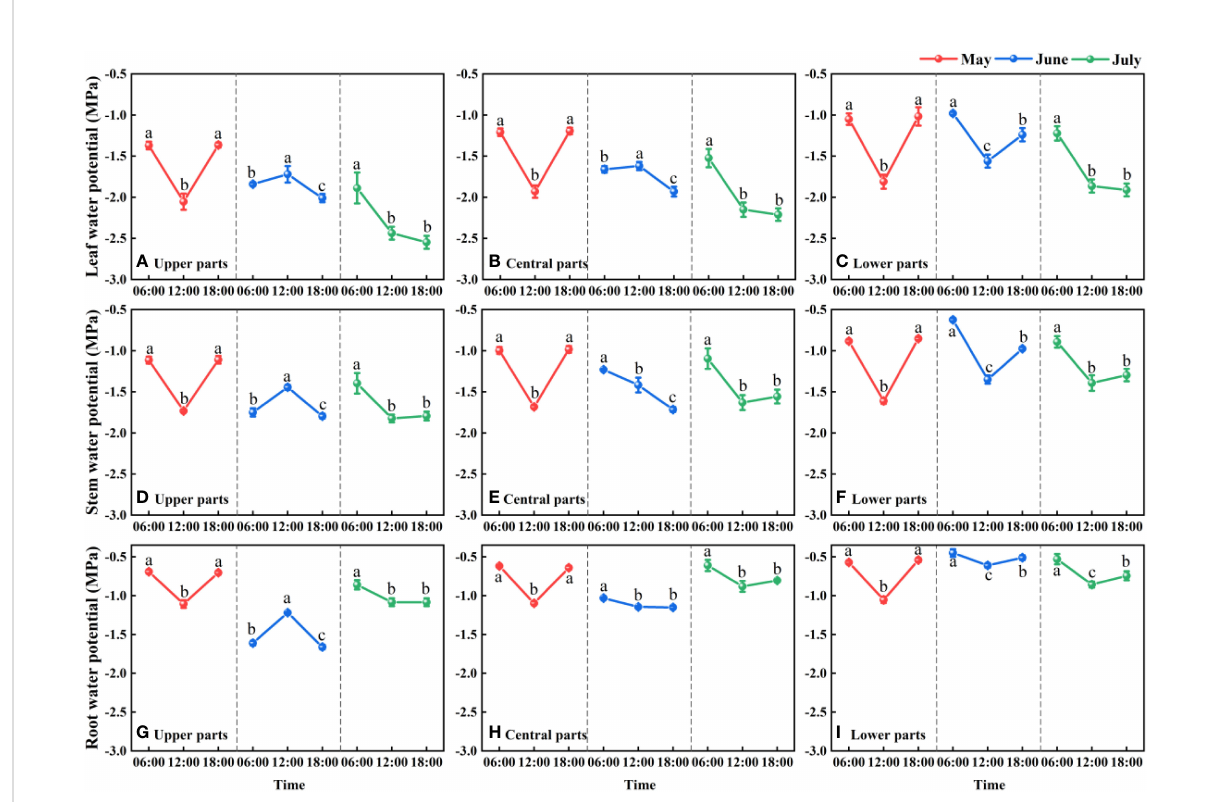
FIGURE 6 Daily and seasonal variations in the leaf (A-C) , stem (D-F) , and root (G-I) water potentials for Ferula bungeana growing on mega-dunes in the Badain Jaran Desert during the 2020 growth season. Data are presented as the means ± 1SE. Different lowercase letters indicate signi fi cant differences in water potential at different times within the same sampling day at the P < 0.05 level of signi fi